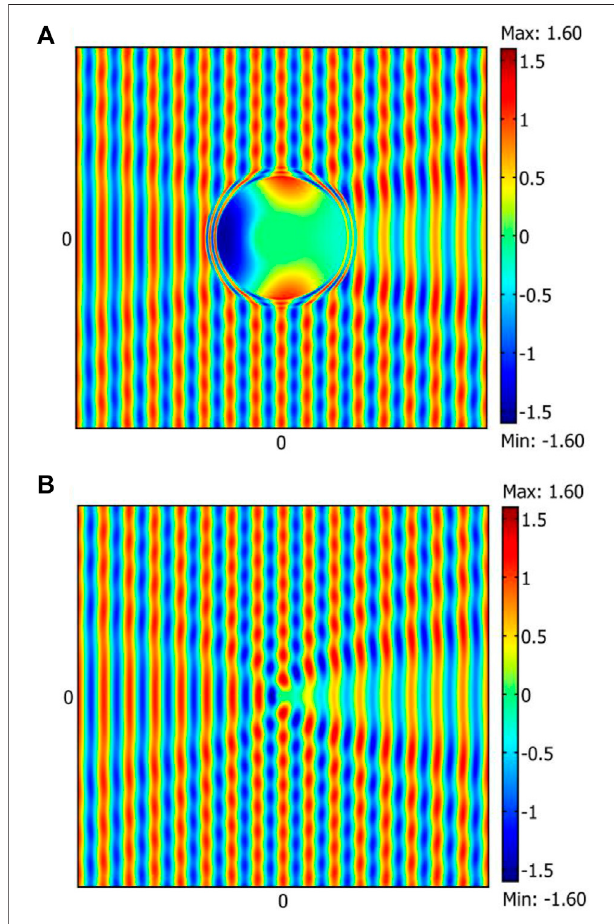
FIGURE 4 | (A) SFP of object placed in core medium of expander illuminatedbyfar fi eld,with b (cid:2) 0 . 3 m , a (cid:2) 0 . 25 m and c (cid:2) 0 . 05 m and d (cid:2) 0 . 1 m as object radius. Theobject here isPEC. ε sample (cid:2) − 10000 and μ sample (cid:2) 1 (B) SPF of bare transformed object illuminated by far fi eld, with radius d ′ (cid:2) dc / a . In both plot working frequency is 1